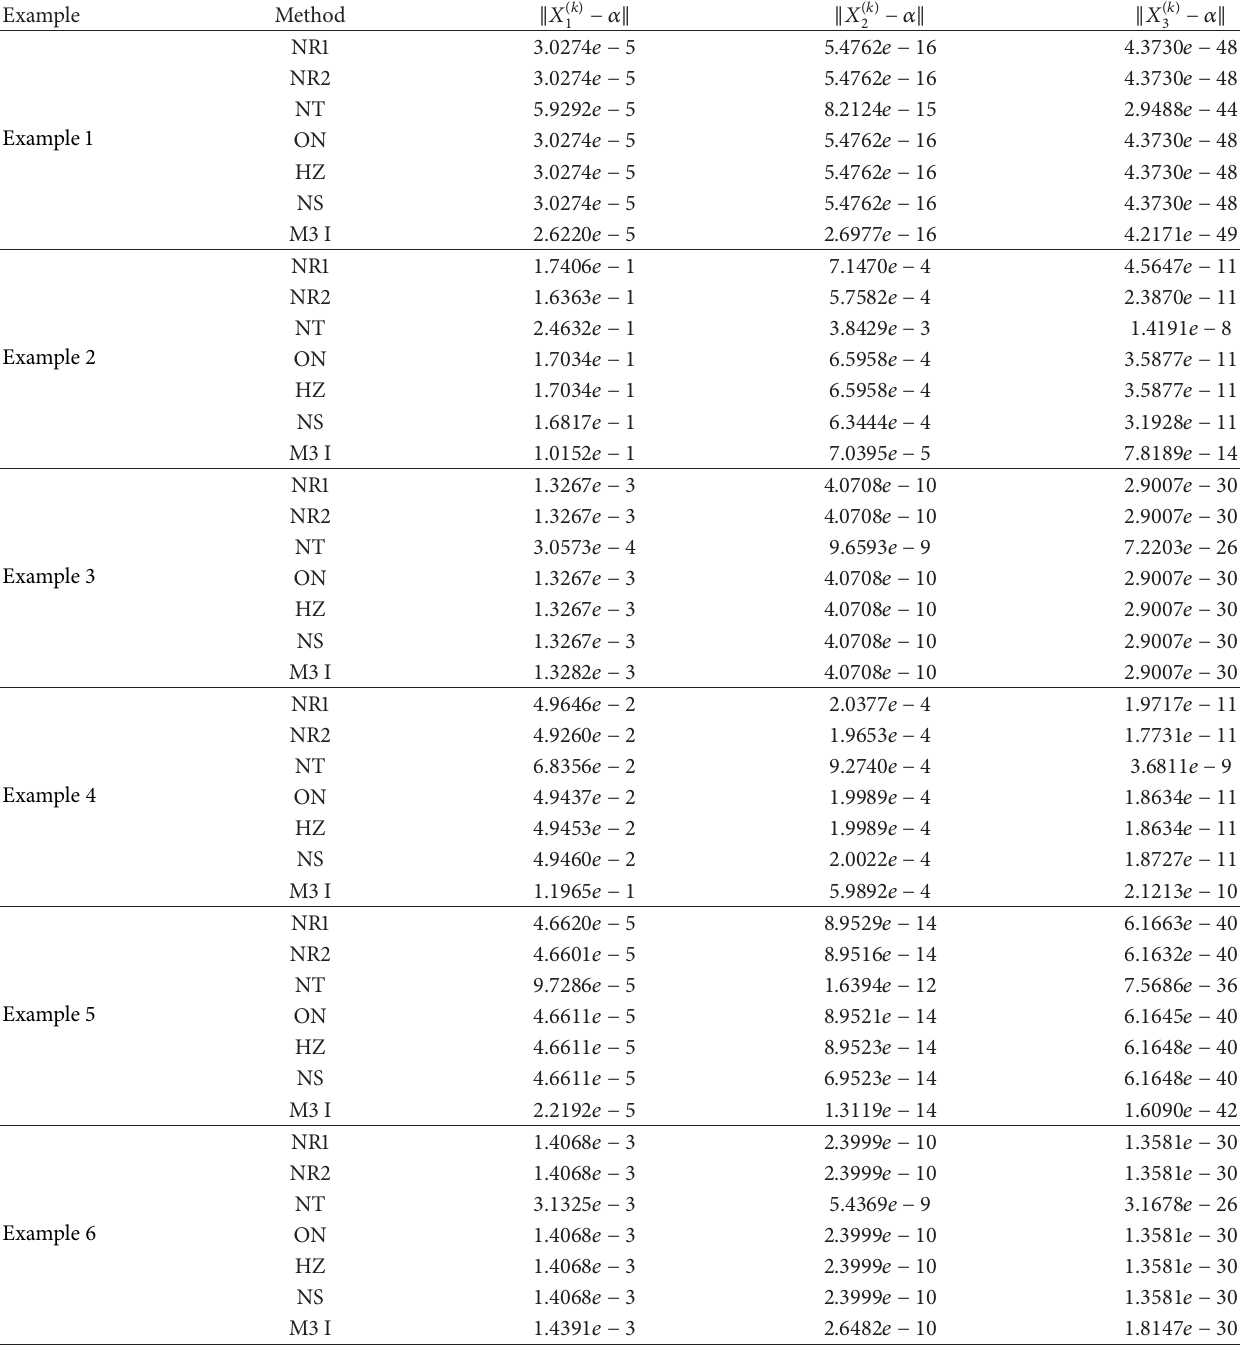
Table 5: Comparison of the norm of the error occurring in the estimates of the exact root with some existing third-order